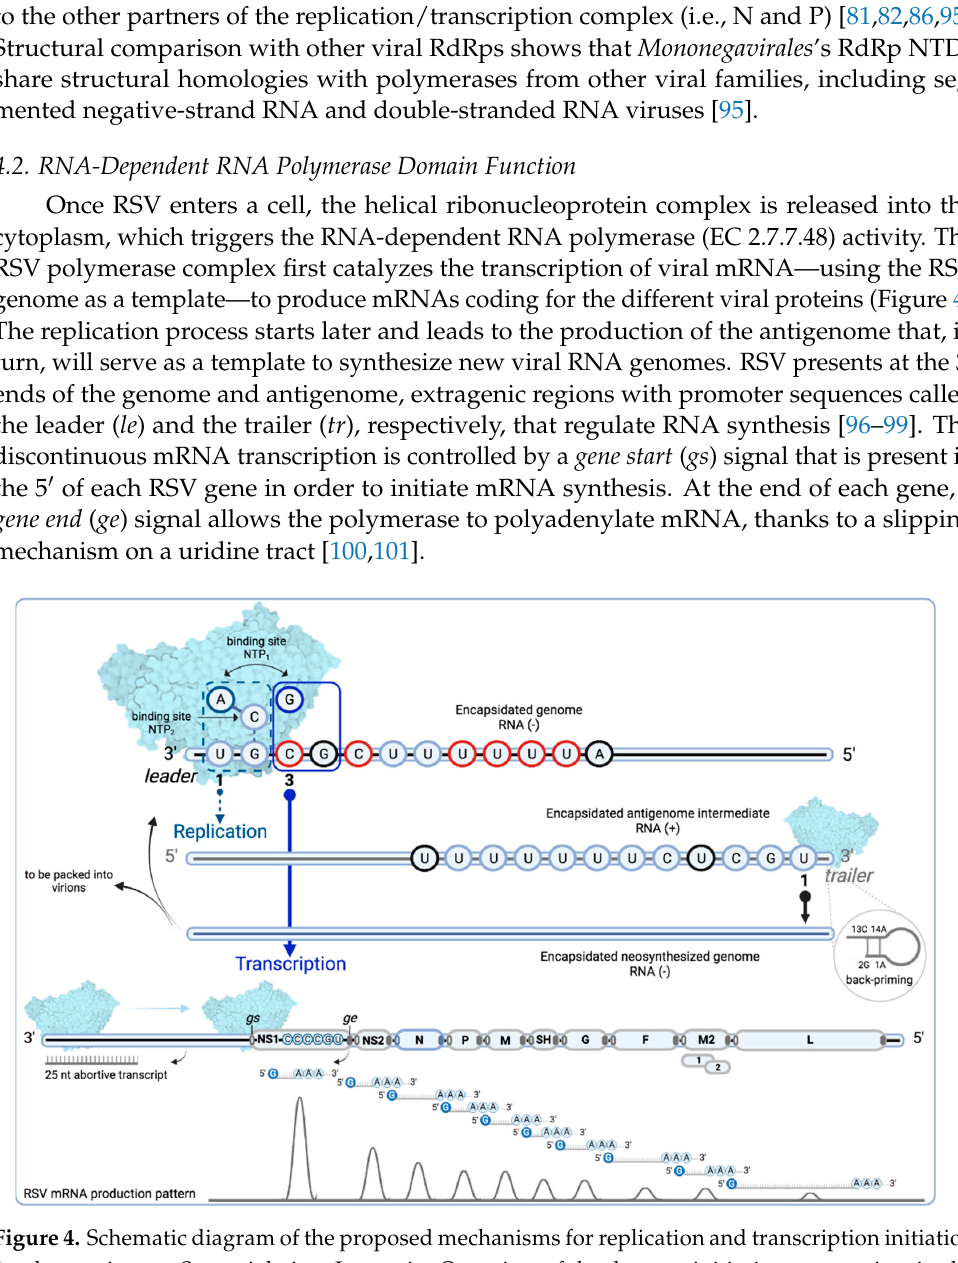
( B ), template entry, and ( C ), double RNA strand exit channels. Reference RdRp position and color coding of sequence motifs of the active site are the same as in Figure 2B. Right panels ( D – F ) are framed with a dashed line to indicate a close up of the active site from the respective left view.